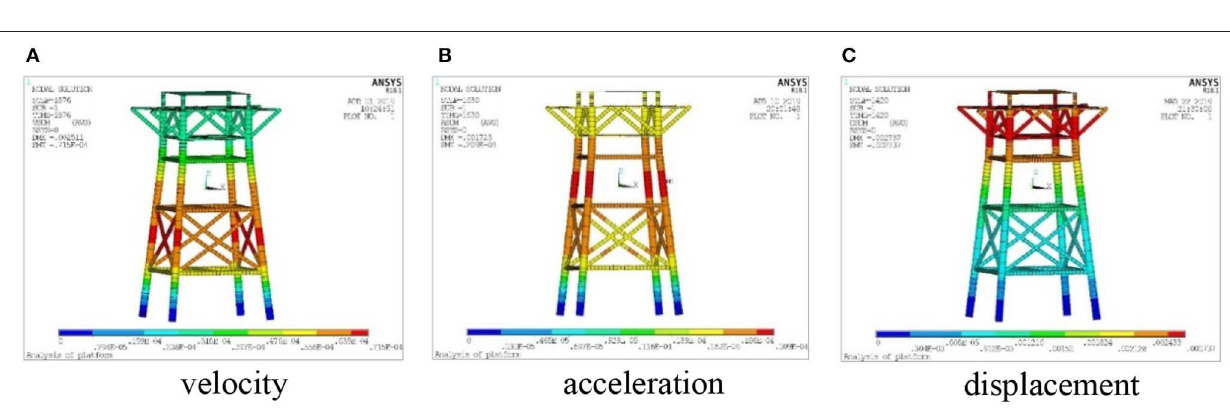
FIGURE 10 | Dynamic response contours under working condition with irregular waves. (A) Velocity; (B) acceleration; (C) displacement.